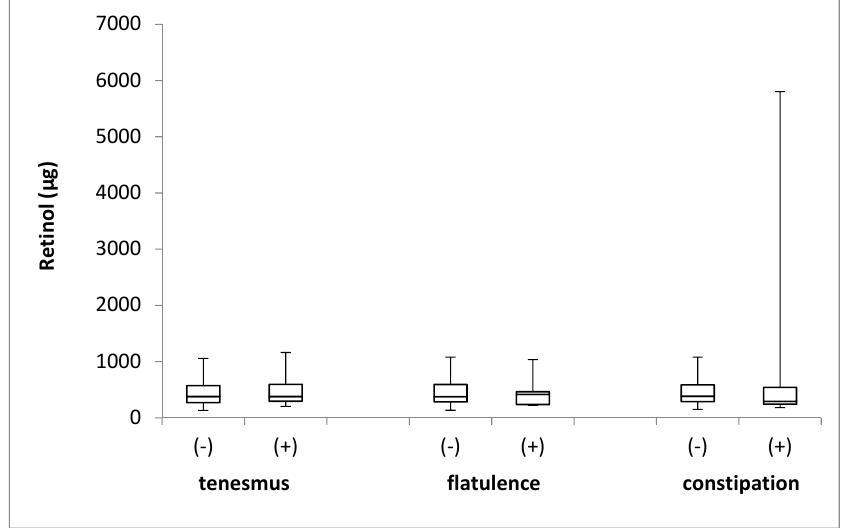
Figure 2. The box plots of retinol intake in groups of individuals stratified by the analyzed symptoms of tenesmus, flatulence and constipation. (-) symptom not declared; (+) symptom declared. The β -carotene intake in the groups of individuals stratified by the incidence of tenesmus, flatulence, and constipation is presented in Figure 3. No differences in the levels of β -carotene intake were identified between the groups, with respect to the incidence of tenesmus ( p = 0.181; Mann– Whitney U test), flatulence ( p = 0.842; Mann–Whitney U test), and constipation ( p = 0.638; Mann– Whitney U test).